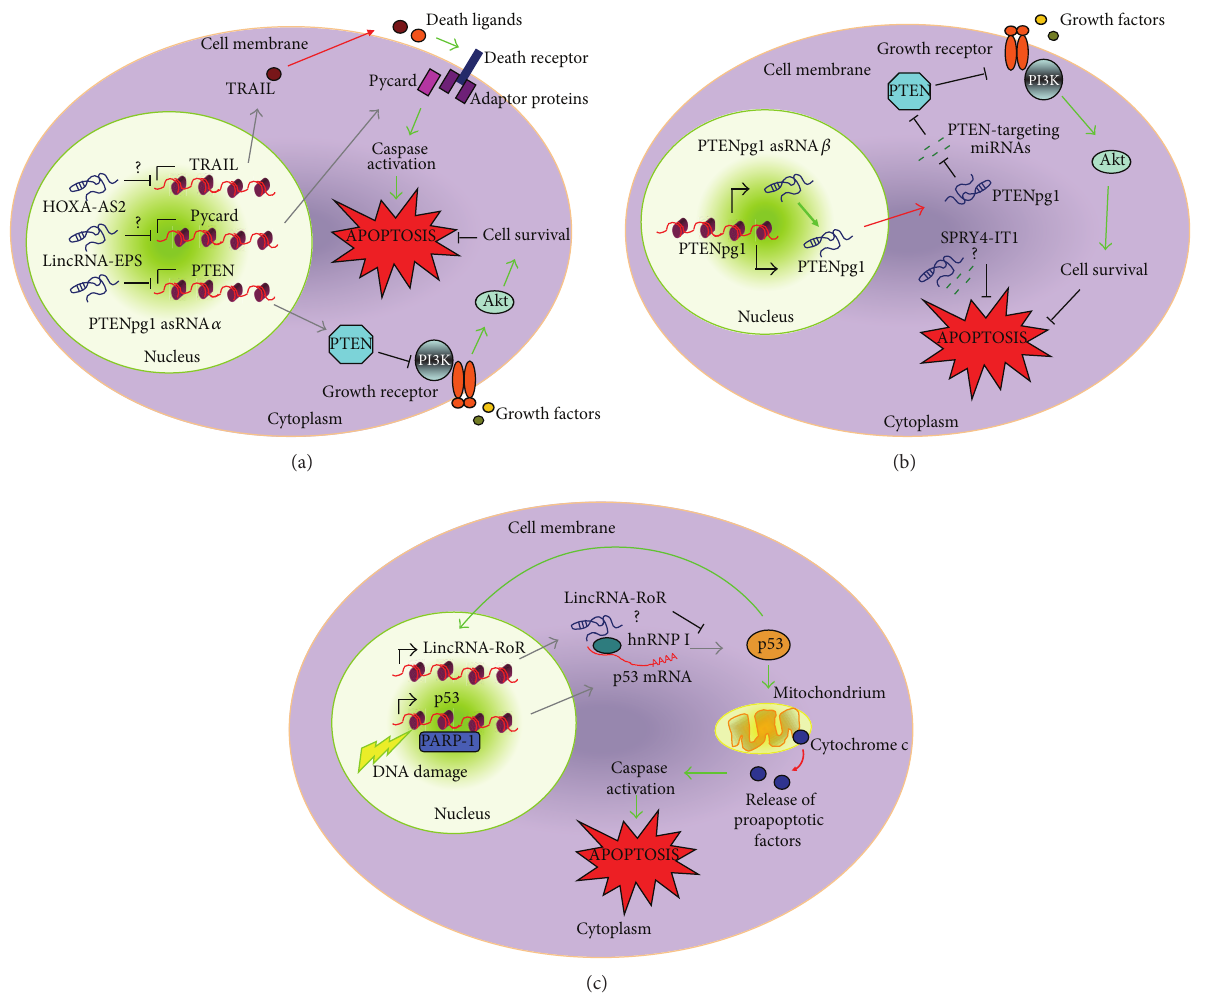
Figure 1: Schematic view of the different mechanisms through which lncRNAs can modulate apoptosis. (a) Transcriptional inhibition, as reported for PTENpg1 asRNA and proposed for HOXA-AS2 and LincRNA-EPS towards PTEN , TRAIL, and Pycard genes, respectively. (b) miRNA sponge. PTENpg1 can function as decoy for PTEN mRNA-targeting miRNAs; similar mechanism has been supposed for SPRY4-IT1. (c)InhibitionofmRNAtranslation.LincRNA-RoRhasbeenhypothesizedtointeractwiththemRNAbindingproteinhnRNP1modulatingthe translation of p53 mRNA. L-bar arrows indicate gene transcription; T-bar arrows indicate negative regulation; green arrows indicate positive regulation; red arrows indicate release/translocation; grey arrows indicate mRNA translocation/translation; and ? indicates a supposed